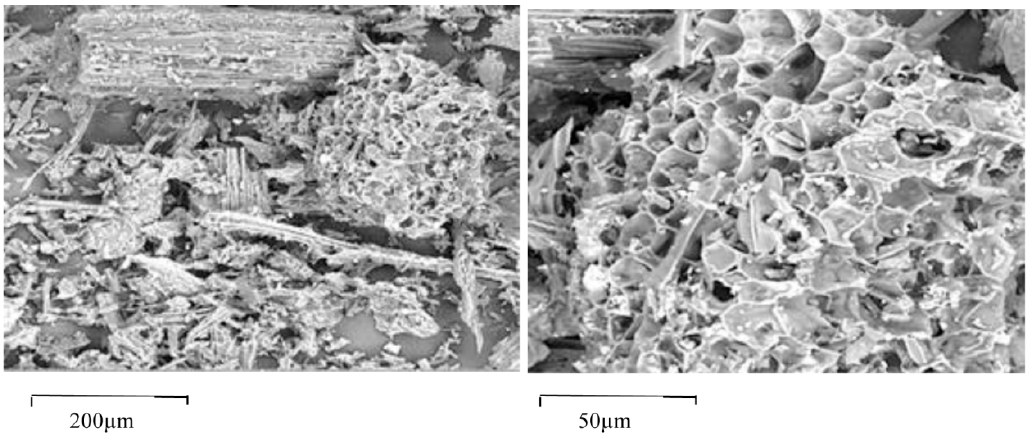
Figure 1. Micrographs of BioC obtained from electron microscope scanning electron microscopy (SEM) TESCAN model, VEGA 3 LMV.